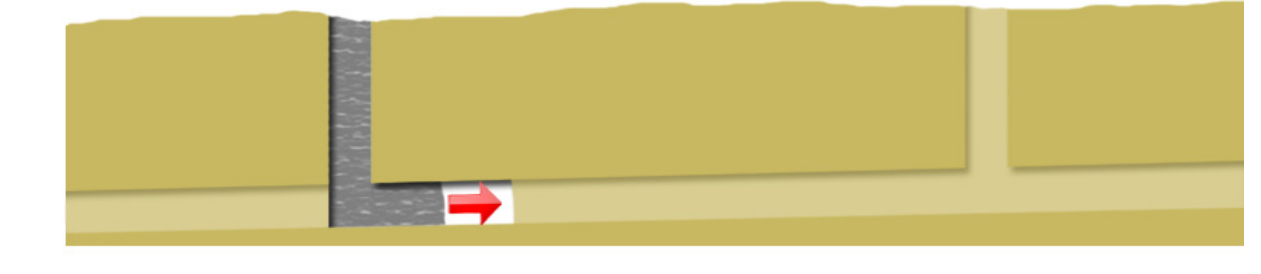
Figure 24. Tunnel coating.